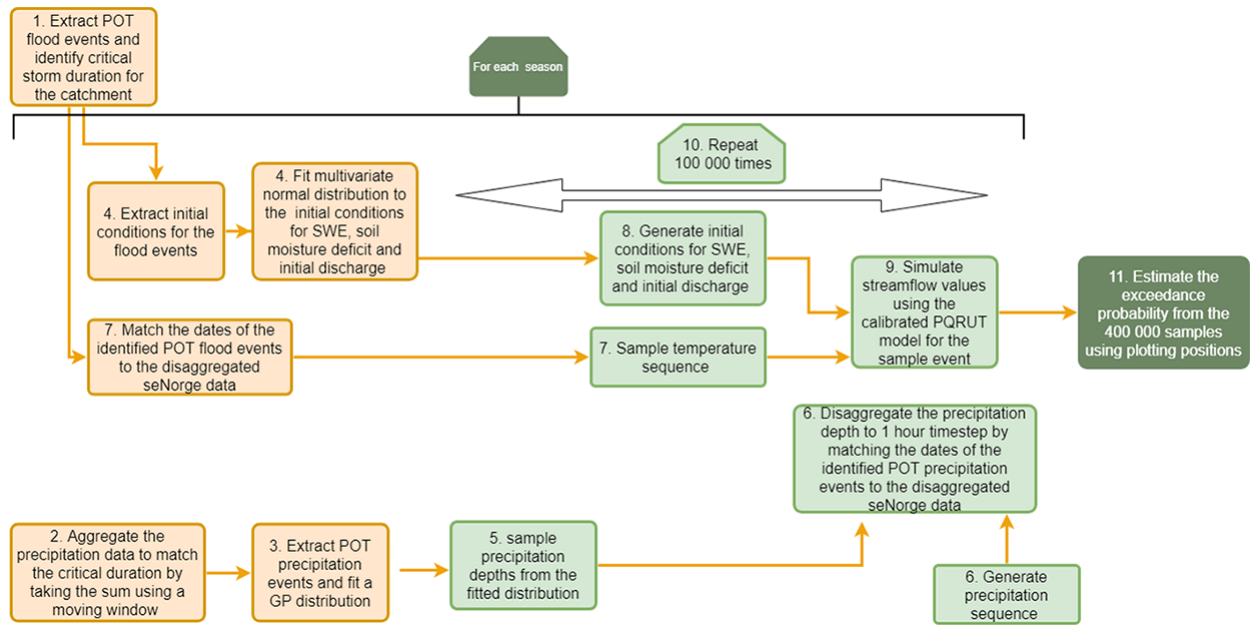
Figure 1. Diagram of the stochastic PQRUT